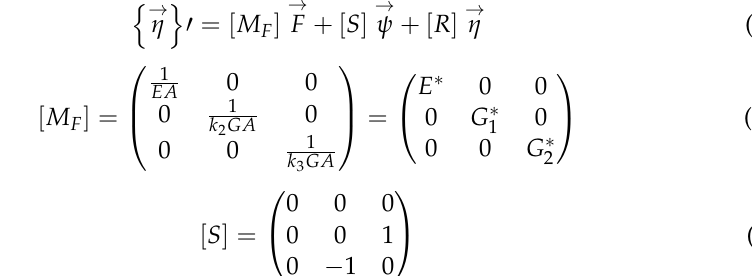
is the bending stiffness along the binormal 3